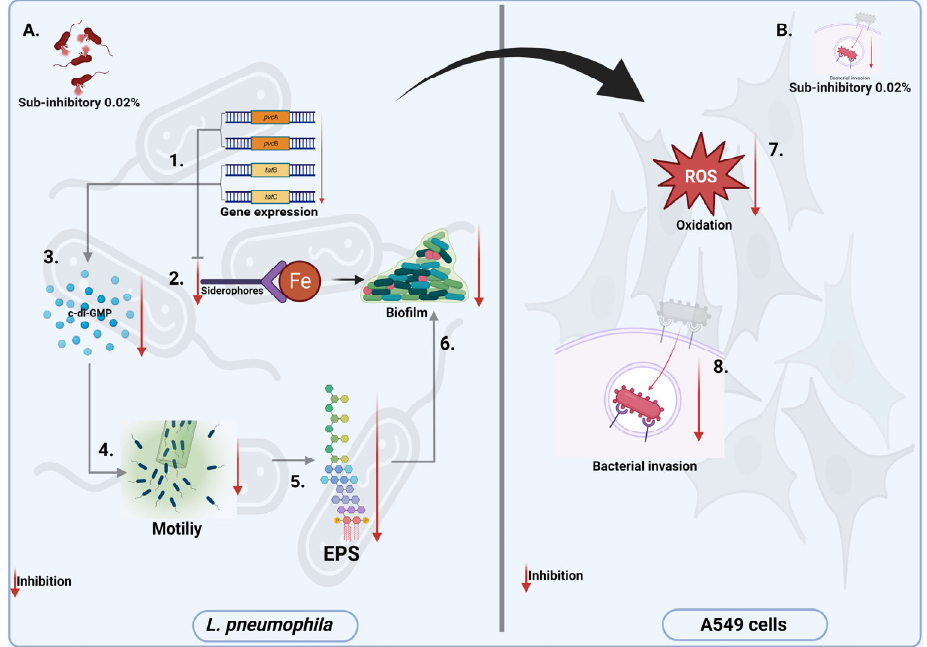
Figure 6. Summary of conclusions. ( A ) In L. pneumophila and ( B ) in A549 cells. Citrox BCL down ‐ regulates the pvc A and B gene expression leading to iron starvation in biofilms by lowering the production of siderophore molecules (1,2,3–6). Causes significant reduction in the production of c-di-GMP molecules (3) and downregulates tat B and C genes expression, reducing bacterial motility (4) and EPS production (5). Citrox BCL at sub ‐ inhibitory concentrations (0.02%) reduces host oxidative stress (7) and inhibits bacterial invasion of A549 epithelial cells (8). Created with BioRen ‐ der.com.